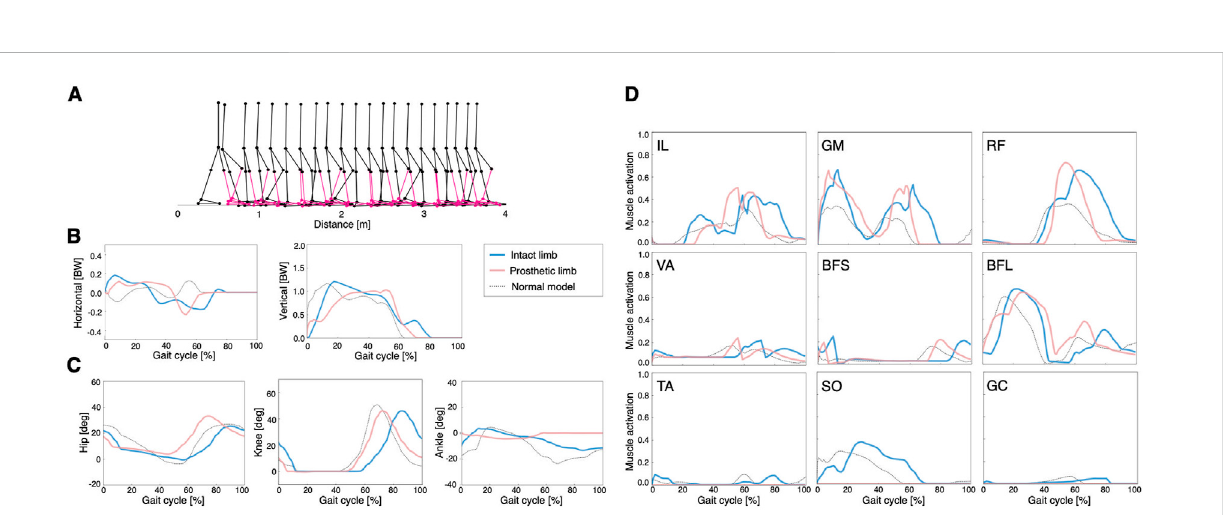
FIGURE 3 Simulation results of the symmetric control model: (A) stick diagram of the symmetric control model with the right ankle muscles removed and replacedbyatranstibialprosthesis(red), (B) groundreactionforces, (C) jointangles,and (D) muscleactivations.Dashedlinesrepresentdataofthenormal model. Blue and red lines indicate intact and prosthetic limbs,